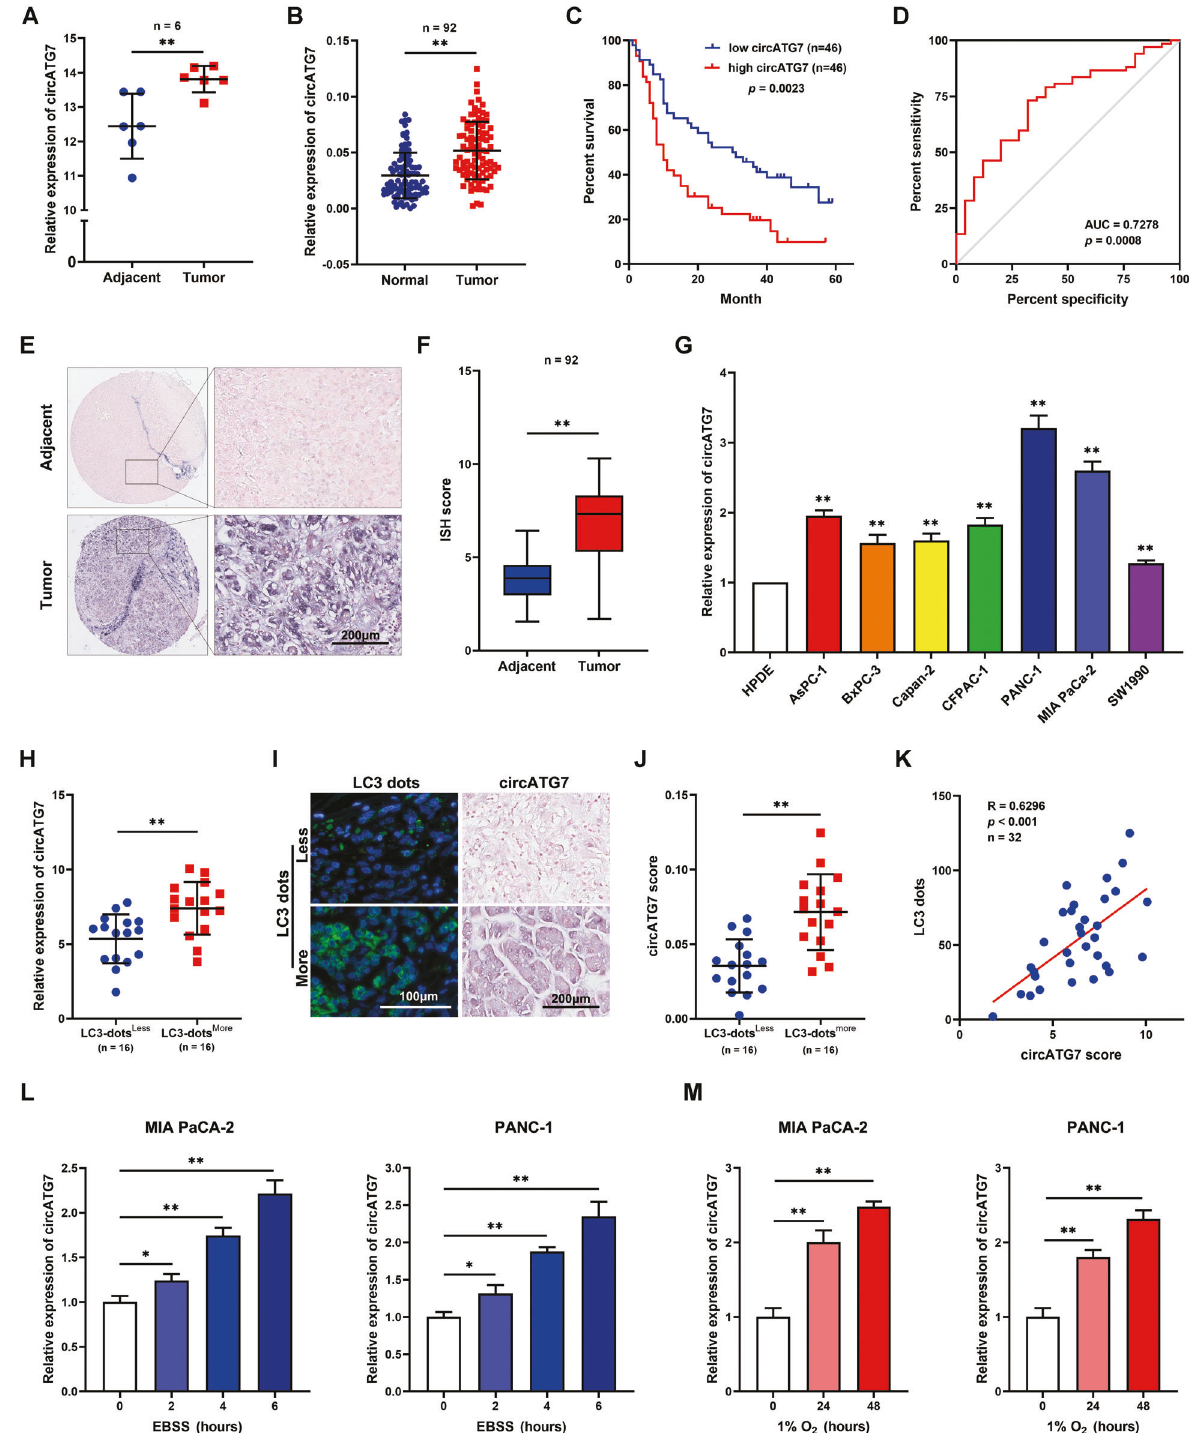
Fig. 1 Autophagy-associated circRNA circATG7 was increased in PC tissues. A has_circ_0064288(circATG7) expression in PC tissues and adjacent tissues based on the expression pro fi le of GSE69362. B RT-qPCR detected the expression of circATG7 in PC tissues and adjacent tissues. C Kaplan – Meier survival analysis showing the overall survival for patients with PC and high or low circATG7 expression. D Receiver operating character curve was obtained to analyze the diagnostic value of circATG7. E , F In situ hybridization was performed to determine the expression of circATG7 in PC tissues. G RT-qPCR was used to determine the expression of circATG7 in normal pancreatic epithelial (HPDE) and PC (AsPc-1, BXPC-3, Capan-2, CFPAC-1, PANC-1, MIA-PaCa2, and PANC-1) cell lines. H RT-qPCR was used to determine the expression of circATG7 in PC tissues with LC3 dots less and LC3 dots more . I , J In situ hybridization was used to determine the expression of circATG7 in PC tissues with LC3 dots less and LC3 dots more . K The relationship between circATG7 expression and LC3 dot number was determined by Pearson correlation analysis. L circATG7 expression in PC cells treated with EBSS. M circATG7 expression in PC cells cultured under hypoxic conditions. * P < 0.05; ** P < 0.01.